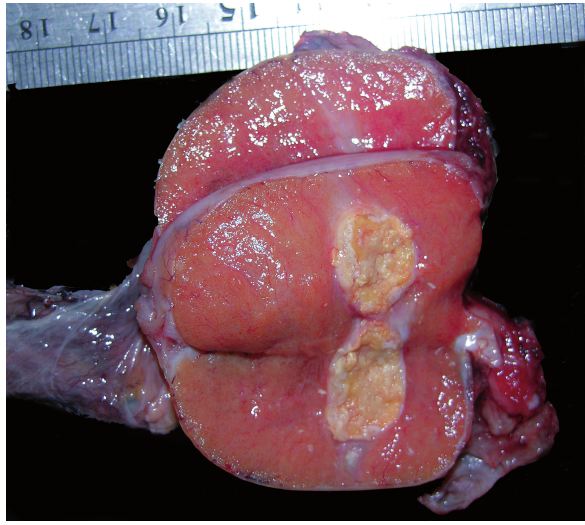
Figure 1 - Macroscopic cut section appearance of testicular calculus.